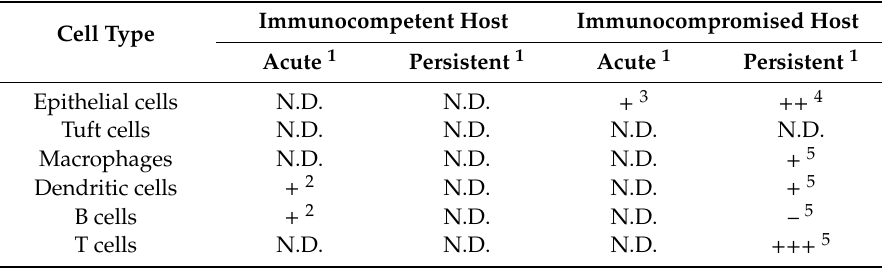
Table 2. In vivo cellular tropism of human norovirus (HuNoV).